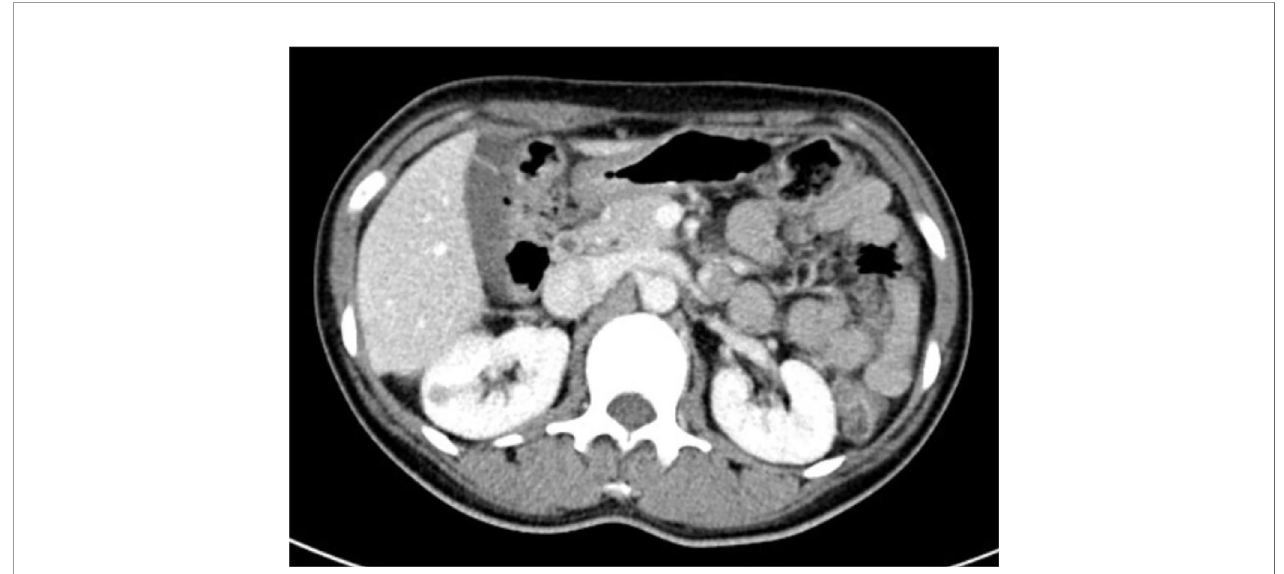
FIGURE 2 | The parenchymal phase of contrast computed tomography image of Patient No.